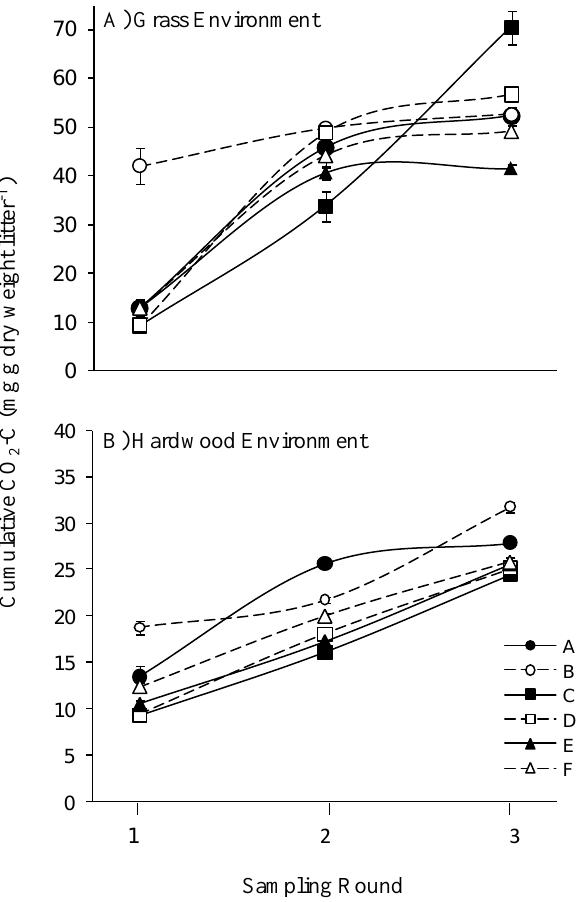
Cumulative litter decomposition across each 100-day sampling round for six different microbial community inocula in grass (A) and hardwood (B) environments. Closed symbols and solid lines represent inocula from grassland sites and open symbols and dashed lines from hardwood sites. Values are means ± 1SE ( n = 6). For clarity, pair-wise comparisons are not shown. How- ever, in each round at least three inocula are significantly different ( P ≤ 0 .